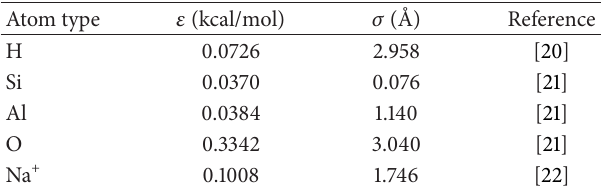
Table 1: Lennard-Jones parameters used for hydrogen adsorption on NaX